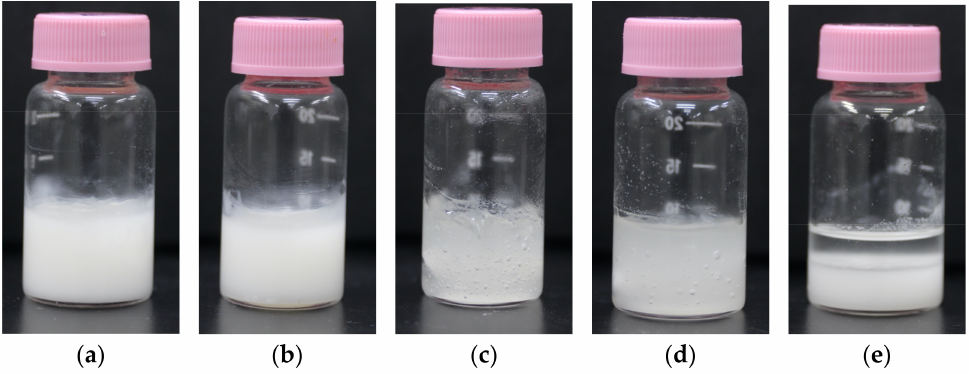
Figure 2. Photos of printer inks: ( a ) Formulation A, ( b ) Formulation B, ( c ) Formulation C, ( d ) Formu- lation D, ( e ) Formulation